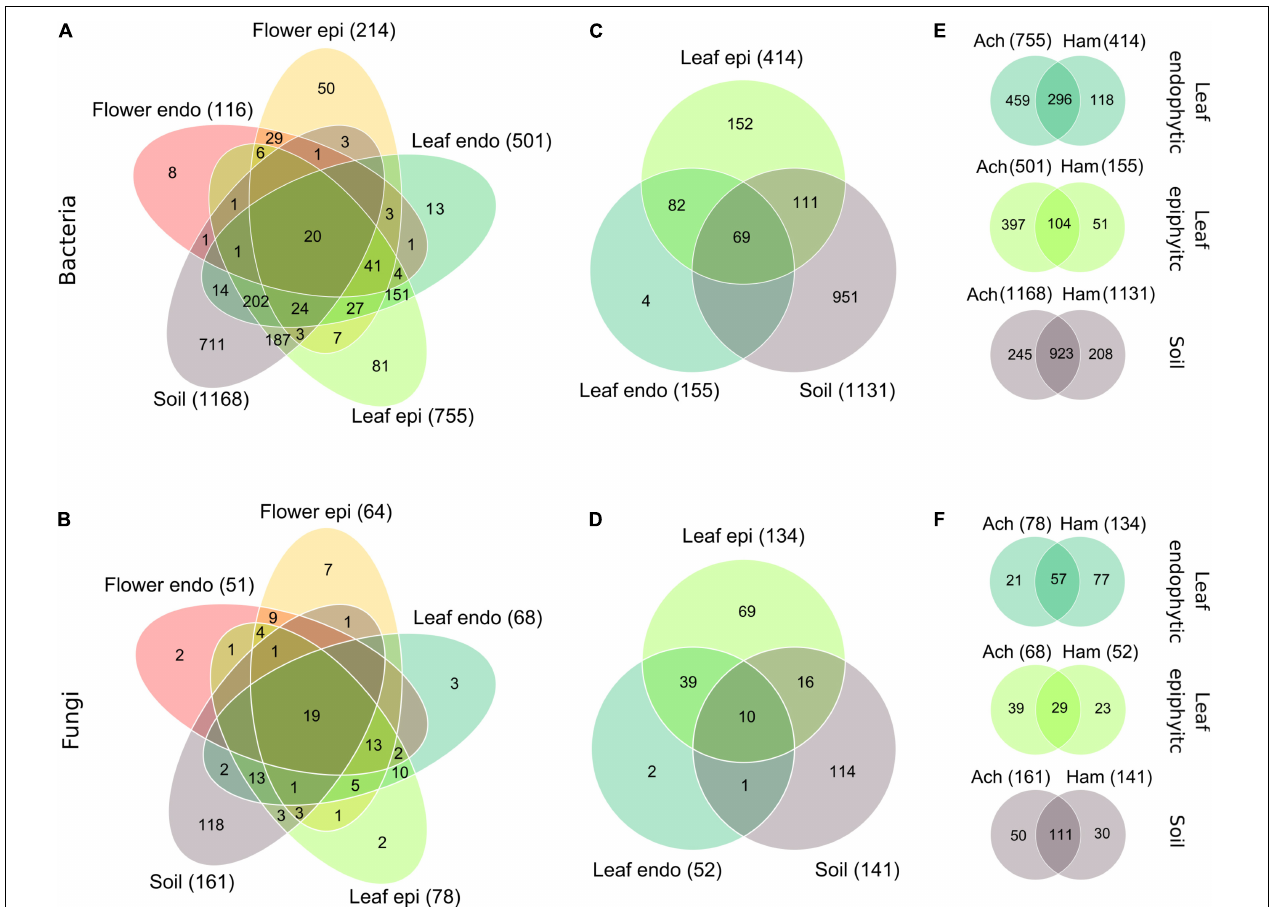
FIGURE 3 | Venn-diagrams of the partitioning of the bacterial species and fungal genera of Achillea (A,B) among the epi- and endophytic leaf, flower and the soil compartments, and of Hamamelis (C,D) among the epi- and endophytic leaf and the soil compartments in July in the WALA garden in 2016 (location 1a). Partitioning of the bacterial species (E) and fungal genera (F) of the endo- and epiphytic leaf and soil communities between Achillea (Ach) and Hamamelis (Ham) is also shown. Intersection without number: detected taxa = 0. In parenthesis: number of compartment-specific taxa.